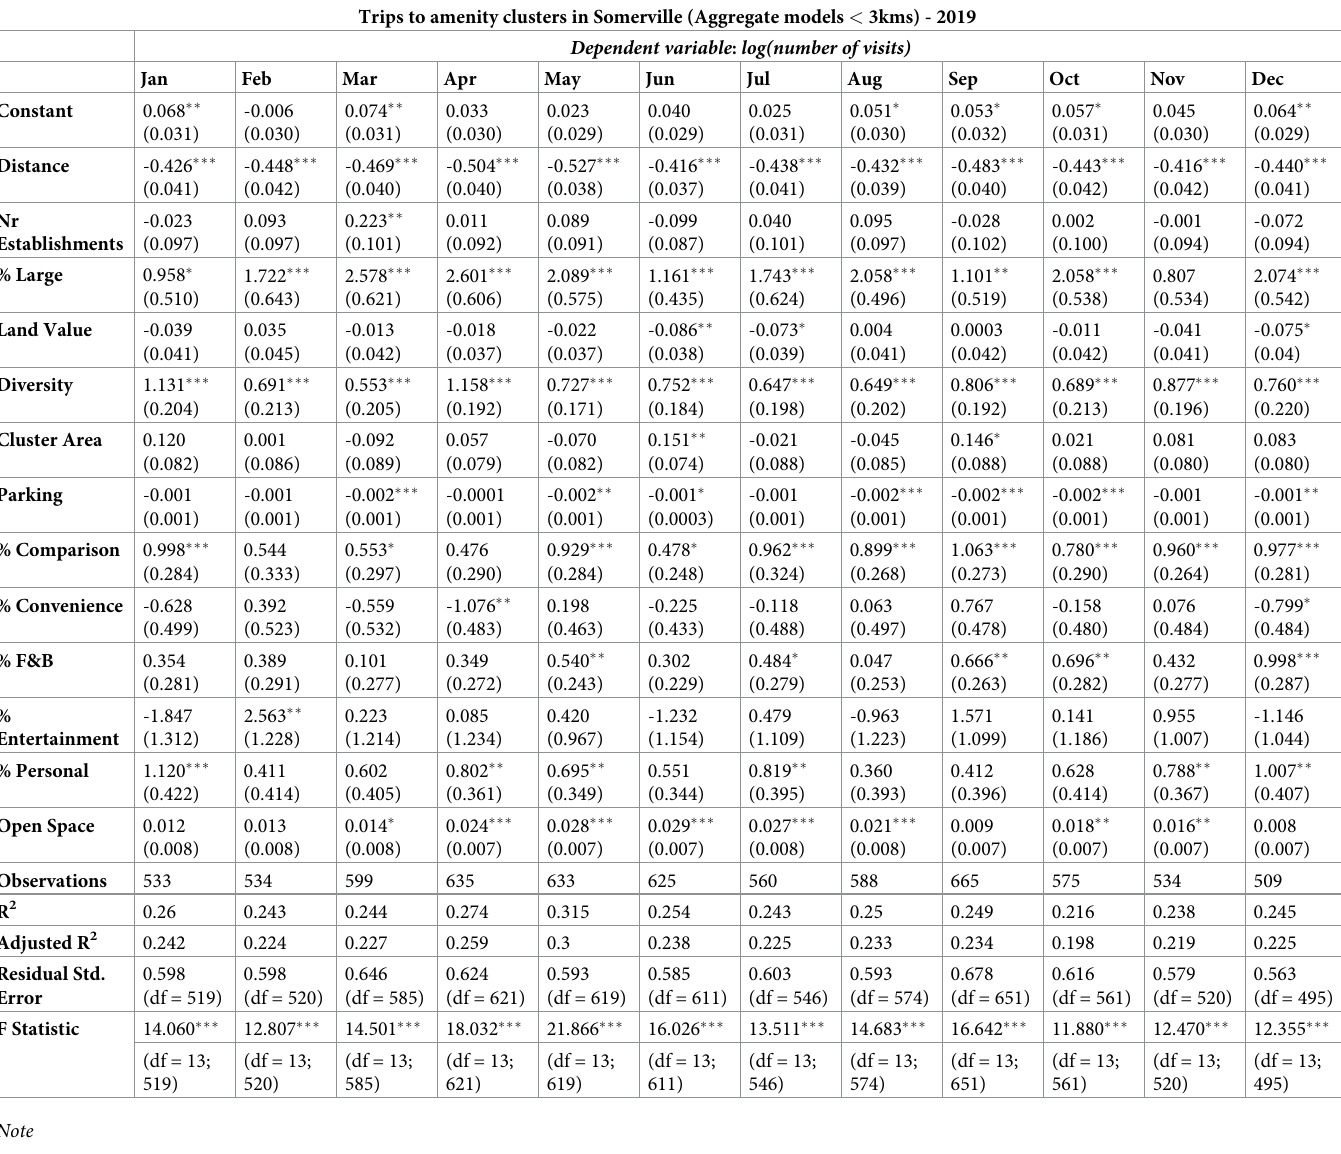
Table 2. Model results for all CBGs, for trips up to 3km in length, in 2019. Trips to amenity clusters in Somerville (Aggregate models < 3kms) - 2019 Dependent variable : log(number of